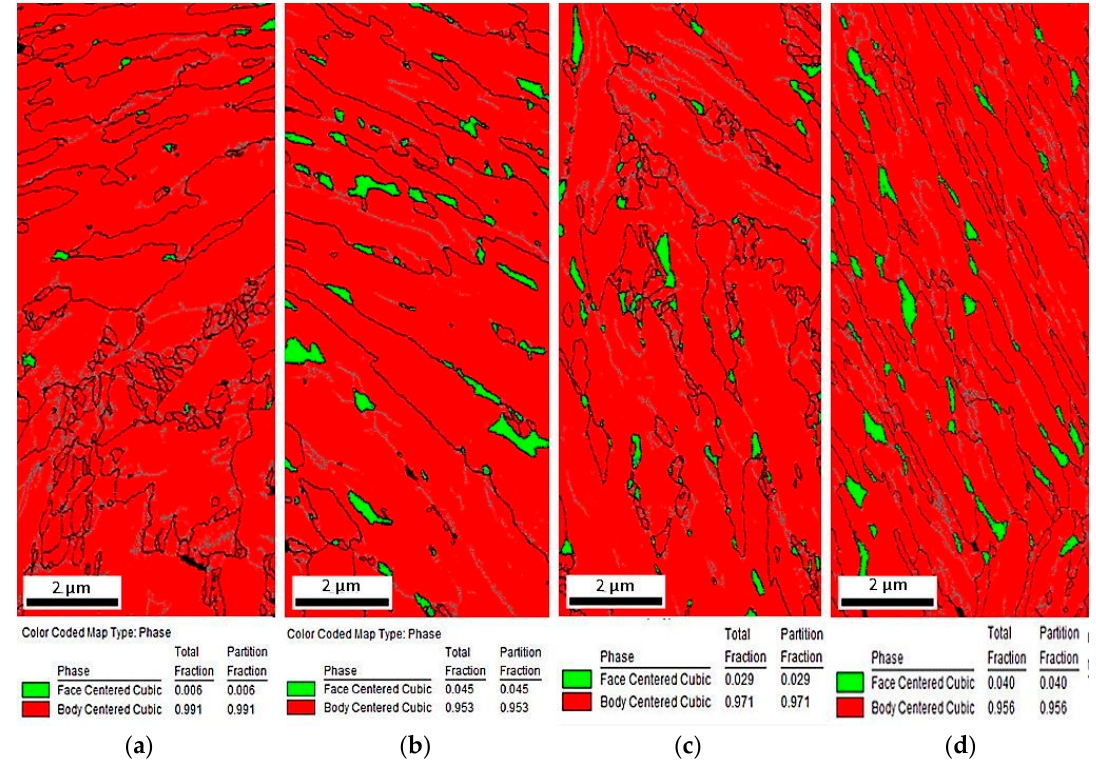
Figure 8. Phase distribution maps (retained austenite (RA) in green) of the investigated steel deformed at: 20 °C ( a ), 60 °C ( b ), 100 °C ( c ), and 200 °C ( d ).